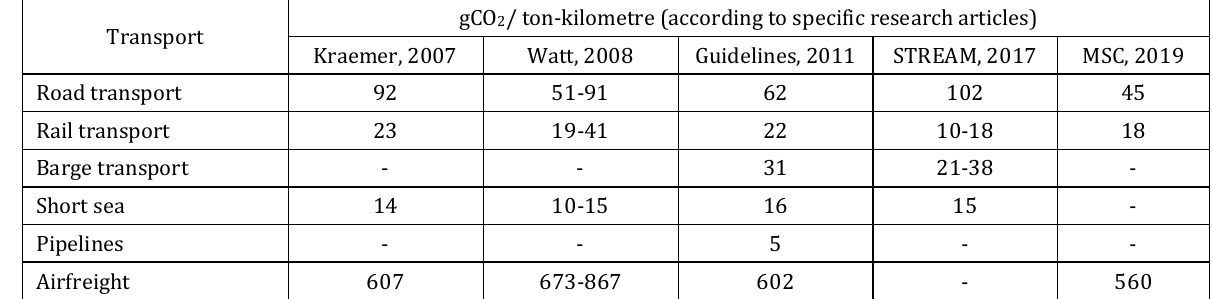
Table 1. CO 2 emissions per ton-kilometre by different modes of transport